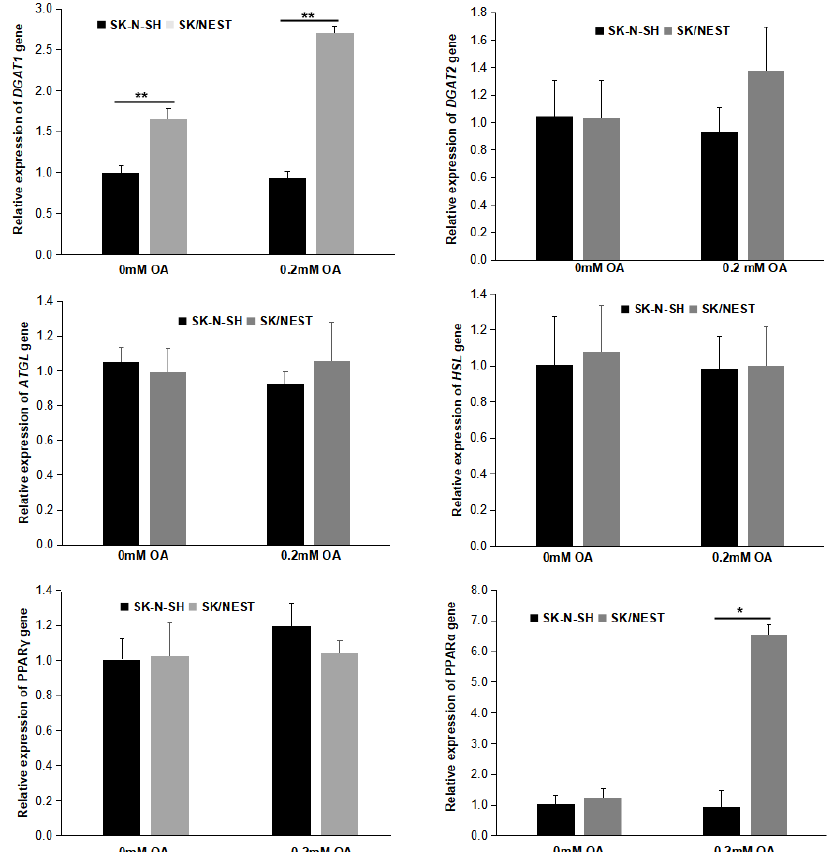
Figure 7. The expression of genes related to TG metabolism affected by NEST overexpression. SK/NEST and SK-N-SH cells were loaded with 0.2 mM OA or not (0 mM OA) for 12 h, and then the total RNA was extracted and transcribed reversely to cDNA. mRNA levels were quantified by qPCR using β - actin as a reference gene and presented as fold change of SK-N-SH cells without OA treatment. Data are presented as means ± SD. Asterisks indicate p values: * p < 0.05, ** p < 0.01, n = 5.